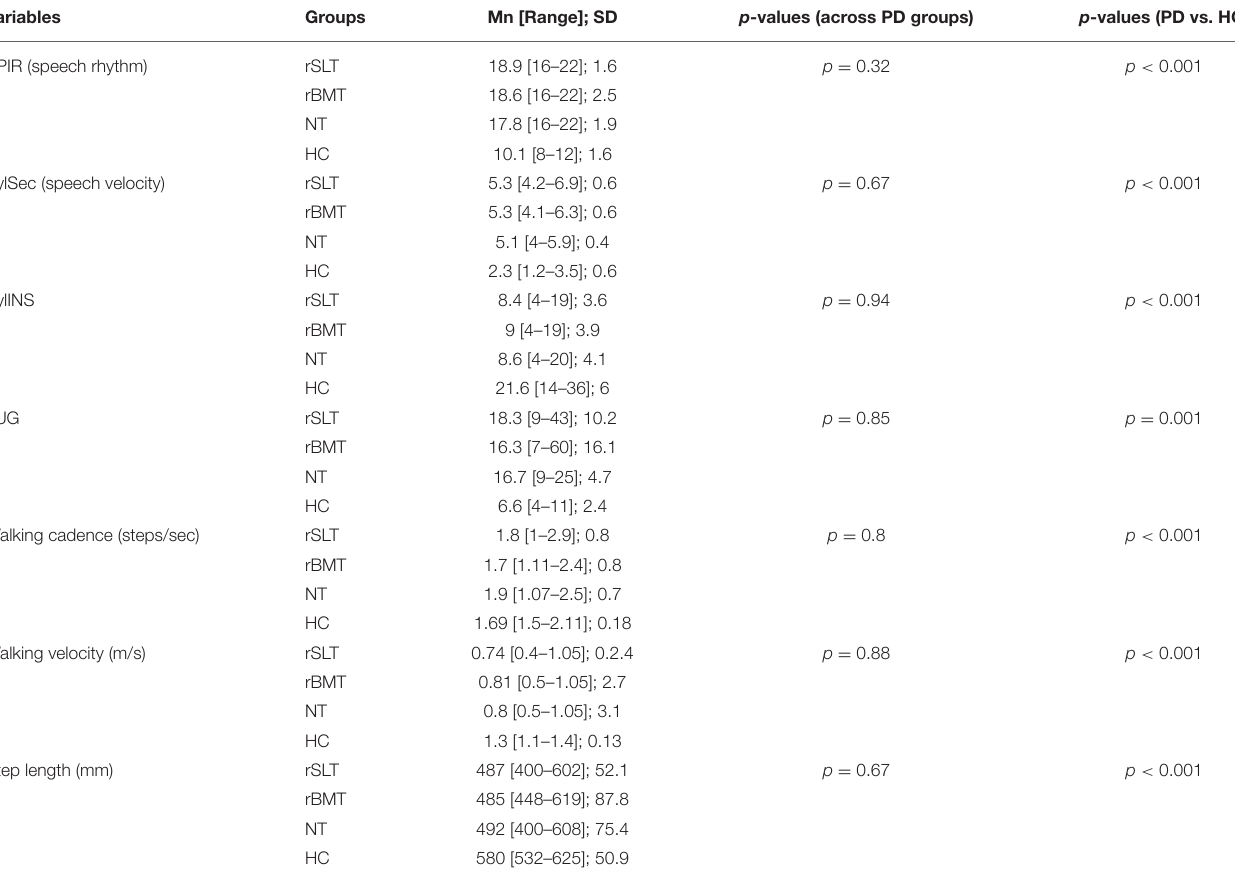
TABLE 3 | Group bias at baseline given per variable. Variables Groups p -values (across PD groups) p -values (PD vs. HC)